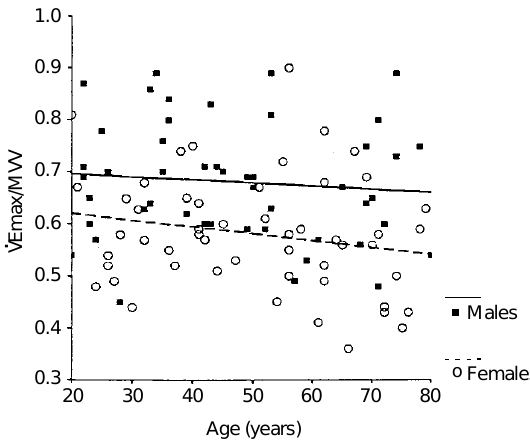
Figure 5 - The ventilatory stress at maximum cycle ergometry . (V Emax/MVV ratio) was lower than one in all subjects, independ- ent of gender. Males showed higher values than females (with an upper 95% confidence limit of 0.87 and 0.77, respectively), but no effect of age was found